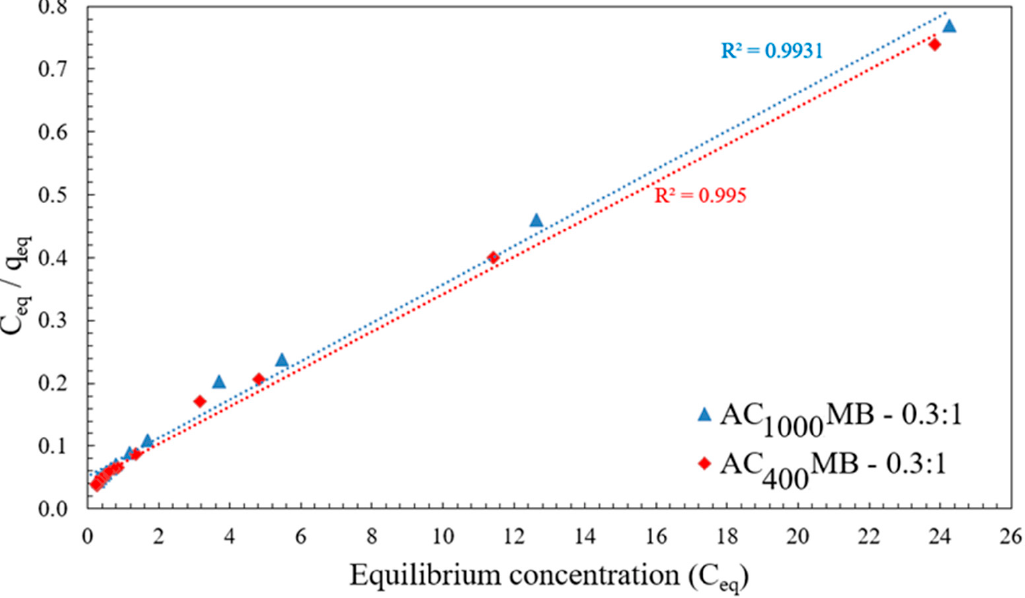
Figure 17. Langmuir isotherm for DB78 dye removal using AC 400°C MB-0.3:1 and AC 1000°C MB-0.3:1. Table 2. Comparison of adsorption isothermal models for adsorbents (AC 400°C MB-0.3:1 and AC 1000°C MB-0.3:1).